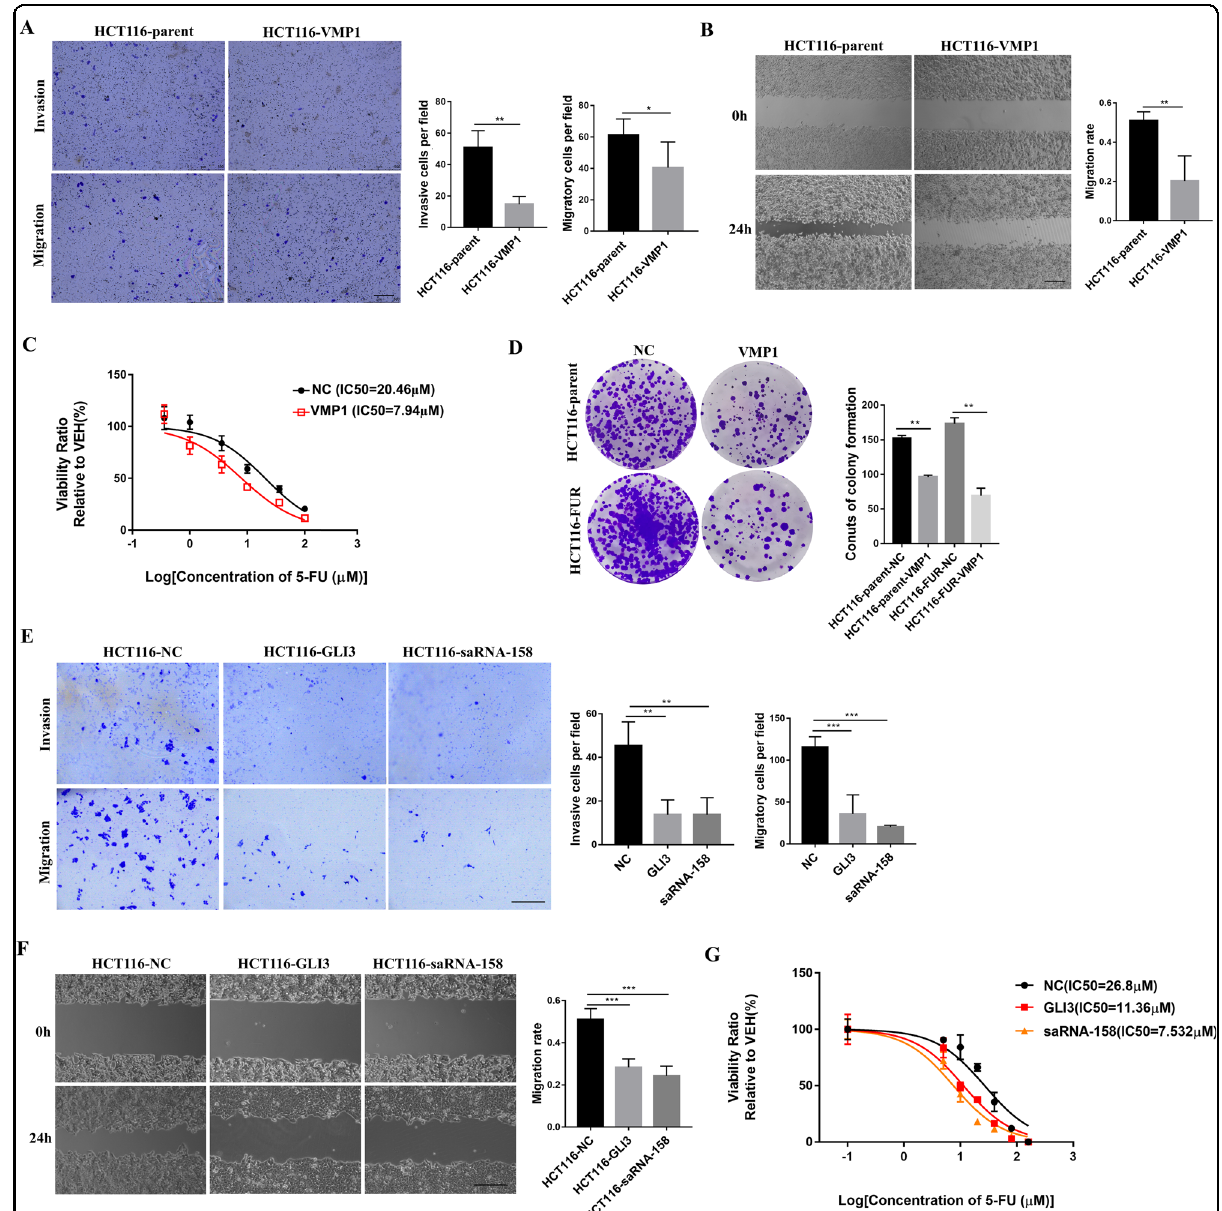
Fig. 6 Breaking the feedback loop of miR-21/VMP1 reduces the malignancy of colon cancer cells. a , b HCT116 with stable overexpression of VMP1 was developed, then the capacity of cell invasion and migration was detected by Tranwell and Wound Healing. c HCT116 was transfected with pcDNA3.1-VMP1 vector, and the cell survival rate to 5-FU was measured by MTT assay. d HCT116 and HCT116-5FUR cells were transfected with pcDNA3.1-VMP1 vector, then 800 cells were seed in the 6-well plate, and cultured for 2 weeks. Number of colonies was measured. e , f HCT116 was transfected with saRNA-158 and pEGFP-C3-hGLI3 vector, then the capacity of cell invasion and migration was detected by Tranwell and Wound Healing. g HCT116 was transfected with saRNA-158 and pEGFP-C3-hGLI3 vector, and the cell survival rate to 5-FU was measured by MTT assay. (Scale bars, 0.5 mm) Data are presented as mean ± SD. *** P < 0.001, ** P < 0.01, * P <